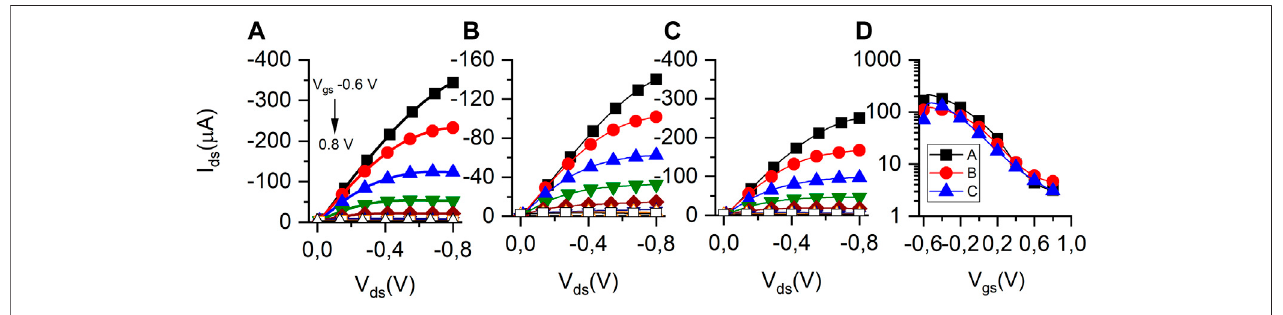
FIGURE7| OutputcurvesofthetransistorsofMixturesA (A) ,B (B) andC (C) preparedbyspincoatingandanappliedgatevoltage:0.6( ■ ),-0.4( C ),-0.2( ▲ ),0( ▼ ), 0.2 ( ◆ ), 0.4 ( q ), 0.6 ( ☐ ), and 0.8 ( △ ) V, at a sweep rate of 60 s. (D) Transfer curves of the transistors of Mixtures A ( ■ ), B ( C ) C ( ▲ ) prepared by spincoating at a V DS of -0.6 V. For visual acuity: the solid lines connect every measured data point and the symbols are drawn at every fi fth data point.